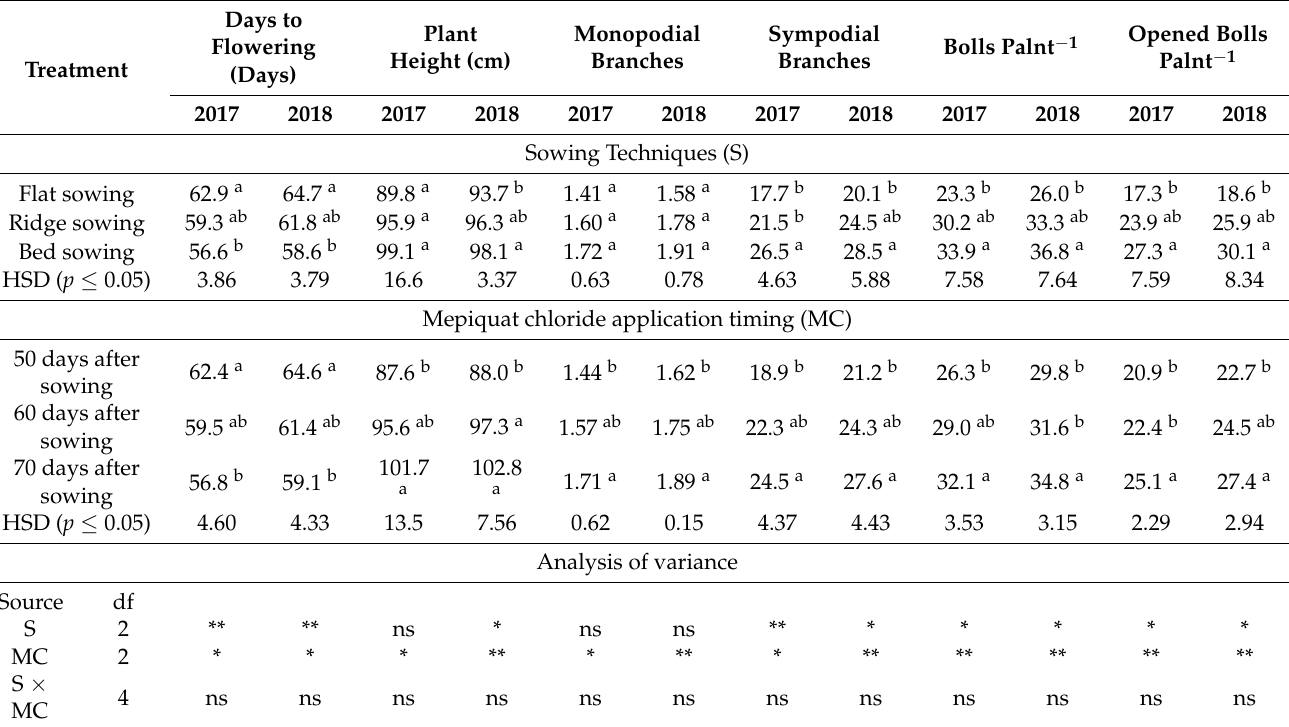
Table 1. Influence of different sowing techniques and timing of mepiquat chloride application on phenological and morphological traits of